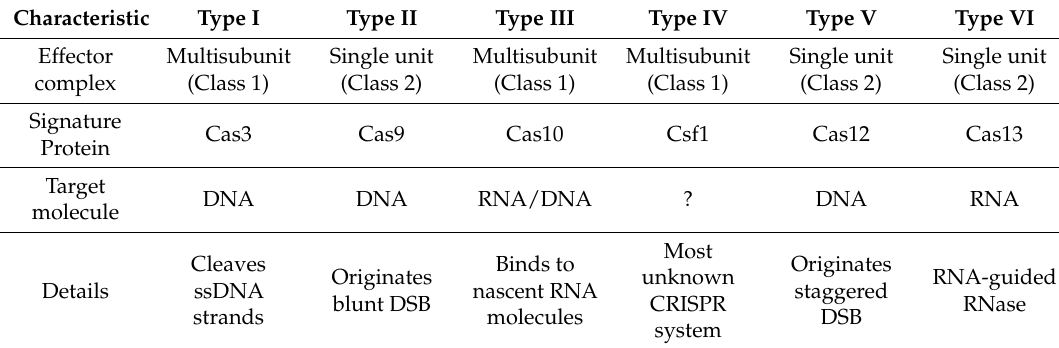
Table 1. Characteristics of different types of clustered regularly interspaced short palindromic repeats (CRISPR)